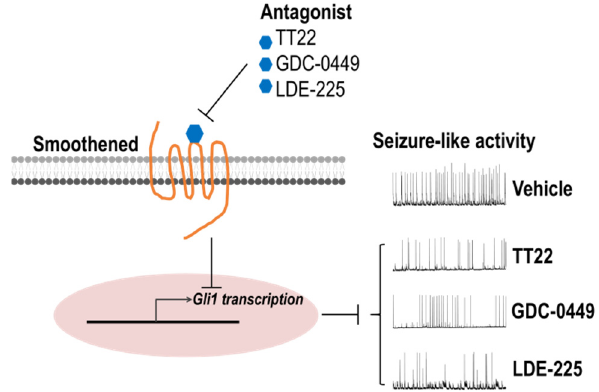
Figure 10. Scheme of the inhibition of Smoothened antagonists on seizure-like activity. Antagonists TT22, GDC-0449, and LDE-225 can bind with a Smoothened receptor, repress its activity, and then inhibit the expression of a downstream Gli1 transcription factor, thus suppressing the abnormal seizure-like activity in hippocampal neurons.